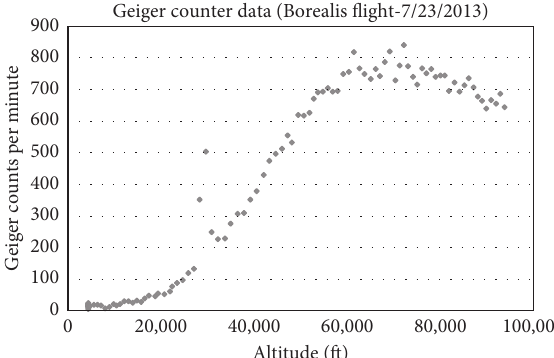
Figure 4: Borealis radiation strike-rate profile [28].